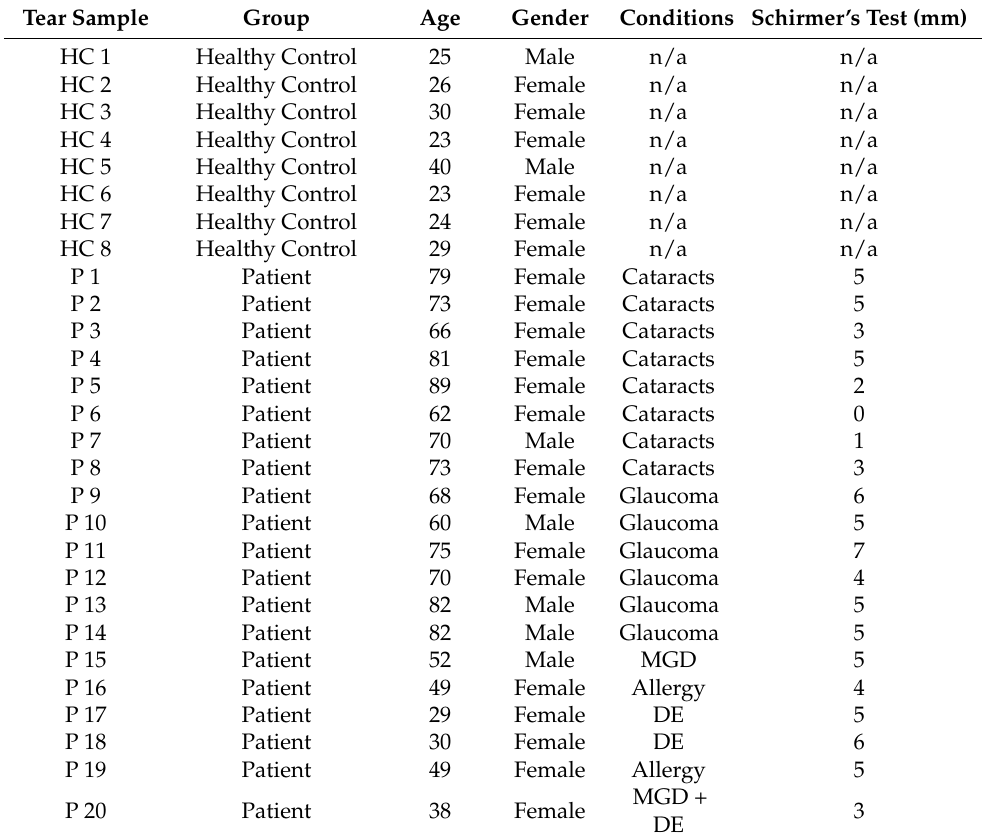
Table 1. Baseline characteristics of the patients and healthy control individuals. The healthy controls were collected from volunteers without any ocular pathology